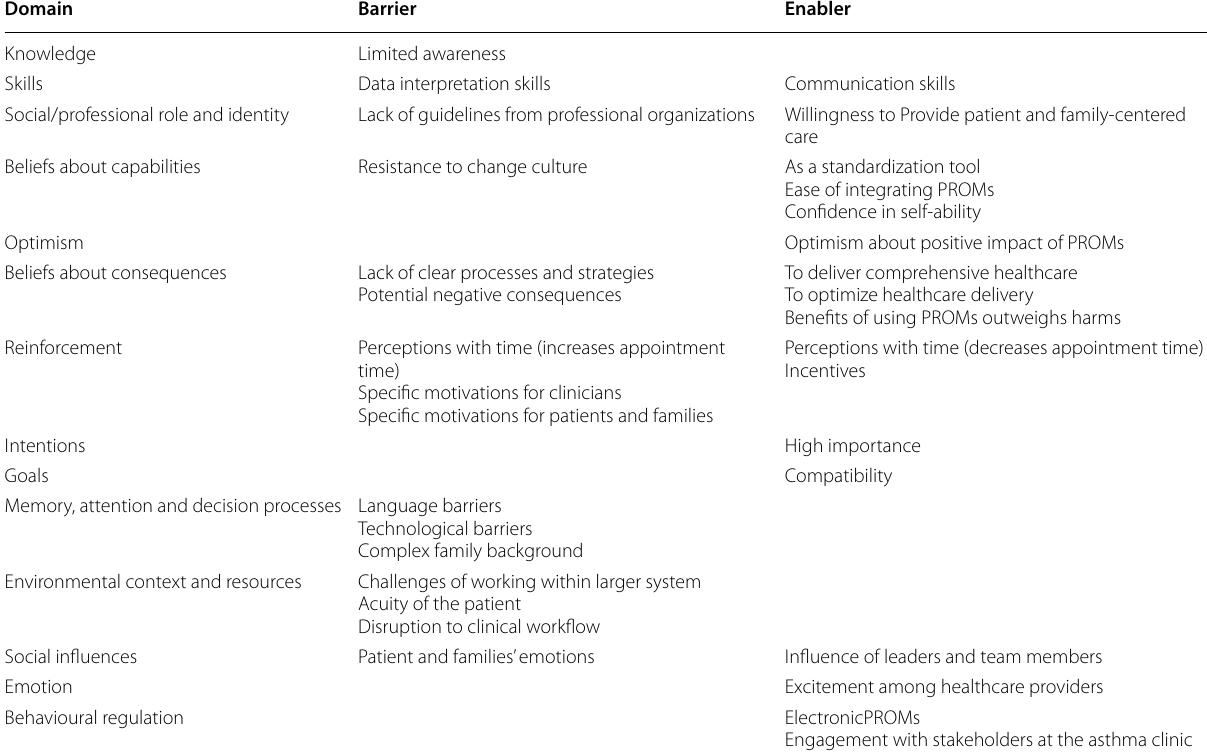
Table 4 Barriers and enablers to implementation of PROMs in pediatric outpatient asthma clinics